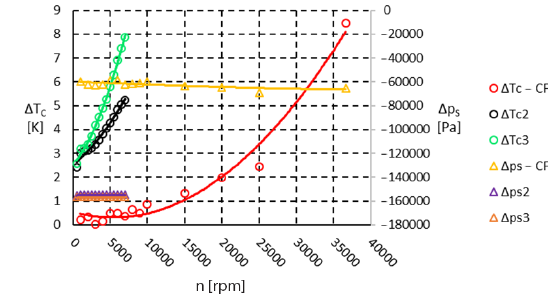
Figure 16. Static pressure and total temperature Table 3. 2 nd degree polynomial trendlines constants